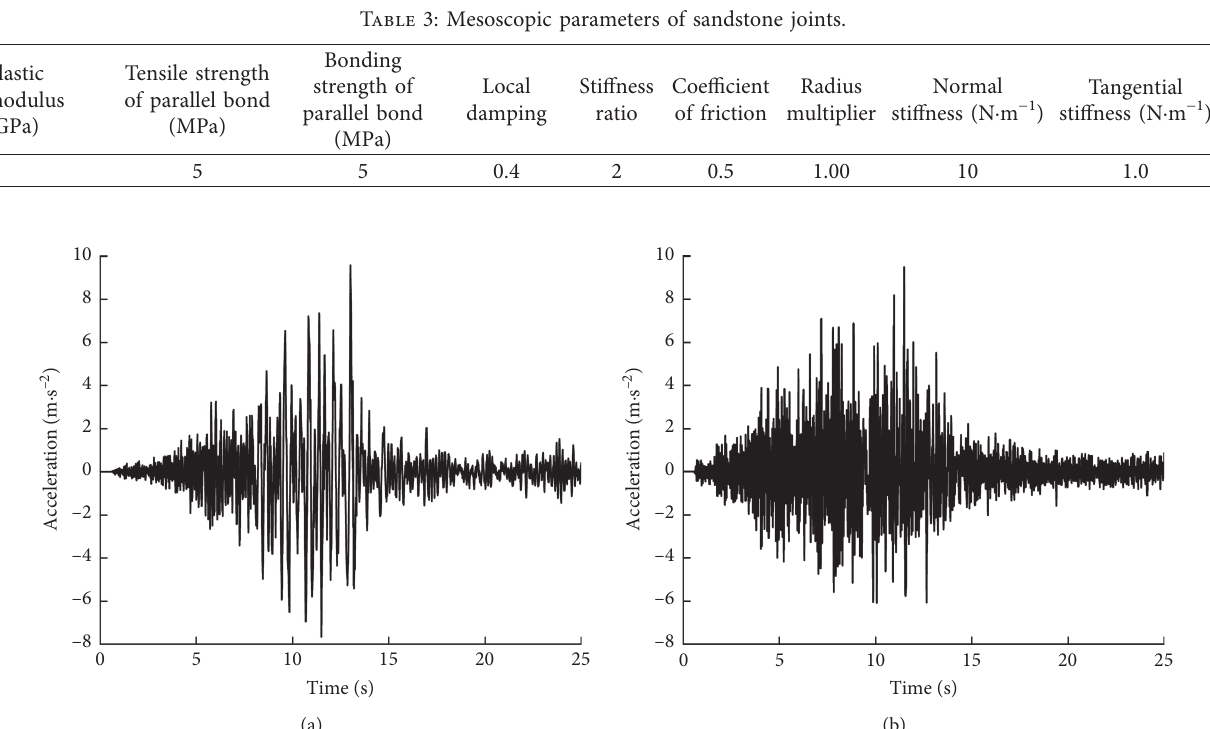
Figure 3: Time-history curve of earthquake acceleration. (a) The time-history curve of the acceleration of the seismic E-W wave. (b) The time-history curve of the acceleration of the seismic U-D wave.